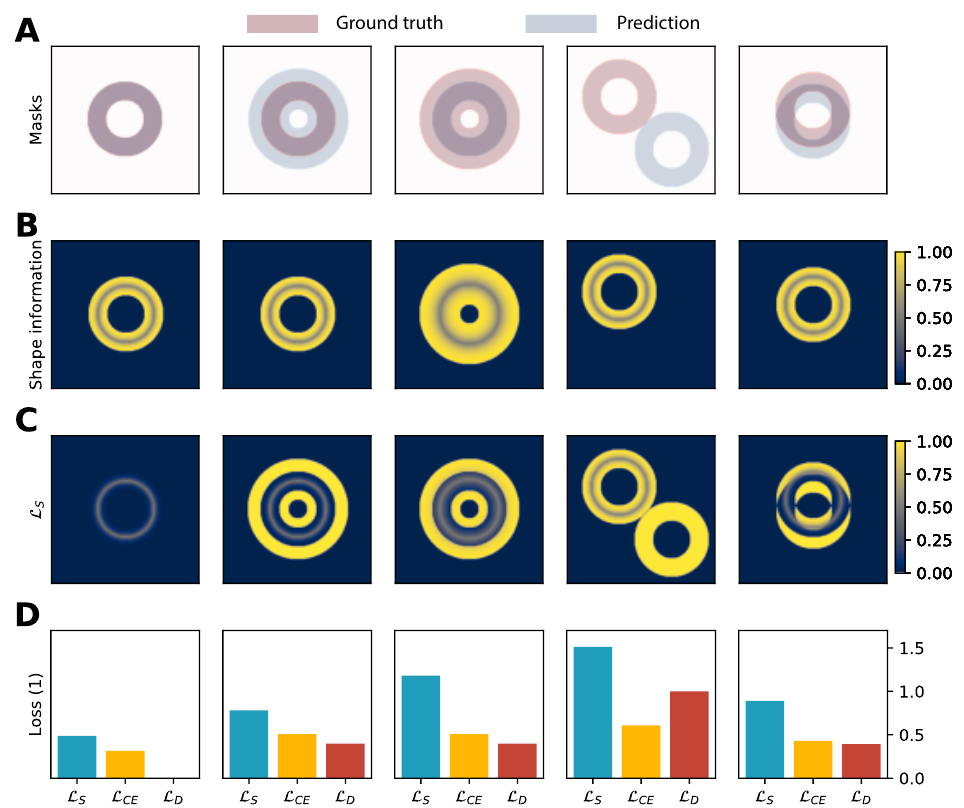
Figure 4. Toy example comparison of the shape-aware loss ( L S ; Equation (3)) to cross-entropy loss ( L CE ) and Dice loss ( L D ), specifically discriminating on the boundary of the ground truth mask. ( A ) Ground truth and prediction masks were used as toy examples. ( B ) Shape information SI of each ground truth mask. ( C ) shape-aware loss L S before channel- and example-wise aggregation as defined in Equation (3). ( D ) Bar-chart of the different